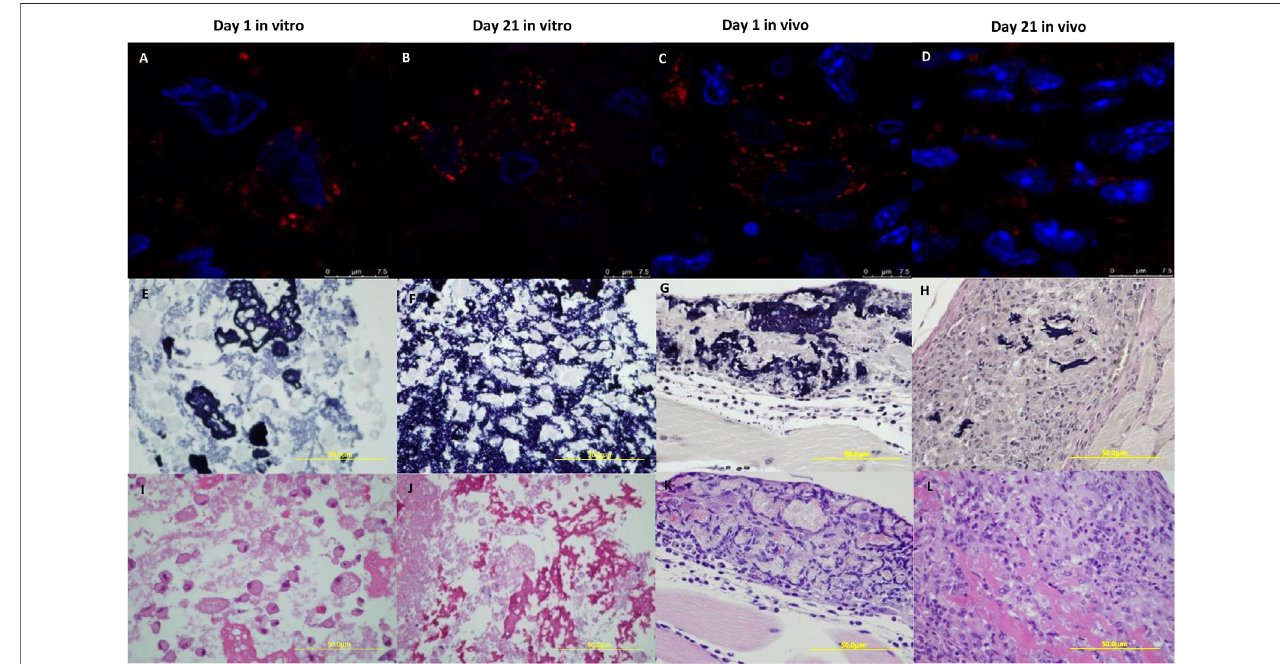
FIGURE 5 | Identi fi cation of BM-MSCs and the ELR-based hydrogel in vitro and in vivo . ELR-hydrogels with BM-MSCs obtained from in vitro and in vivo sections were stained with human mitochondria antibody to identify BM-MSCs (red). Nuclei were stained with DAPI (A – D) . Elastic stain was used to detect the hydrogel (violet) (E – H) . In H&E sections, the ELR hydrogel was stained pink and BM-MSC nucleus was stained violet (I – L) . Experiments were conducted at 1 day (A,E,I) and 21 days (B,F,J) in vitro and at 1 day (C,G,K) and 21 days (D,H,L) in vivo . E-L 60x ampli fi cation.